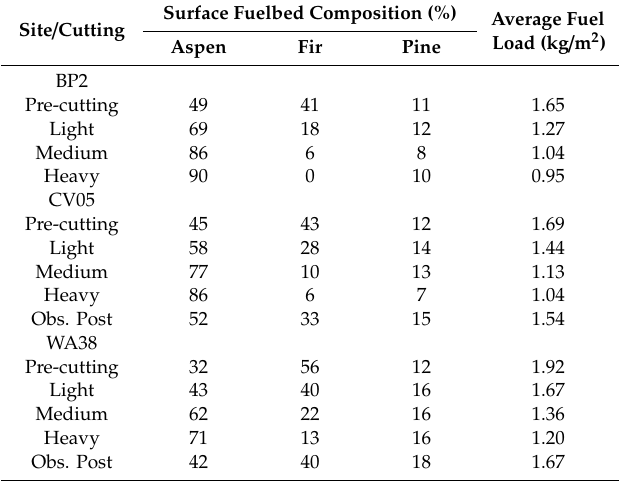
Figure 2. Maps of trees and fuelbed types across three sites (columns) and four scenarios (rows)—pre-treatment, the observed post-cutting, and light and heavy low-cuttings. Trees are colored by species and include quaking aspen (Populus tremuloides; AS), Jeffrey pine (Pinus jeffreyi; JP), red fir (Abies magnifica; RF), and white fir (Abies concolor var. lowiana; WF). Table 3. Characteristics of surface fuelbeds under varying cutting